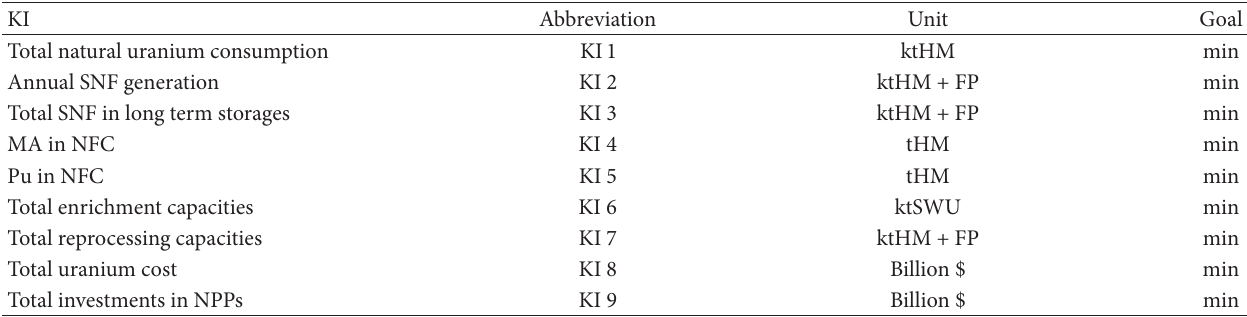
Table 2: Considered key